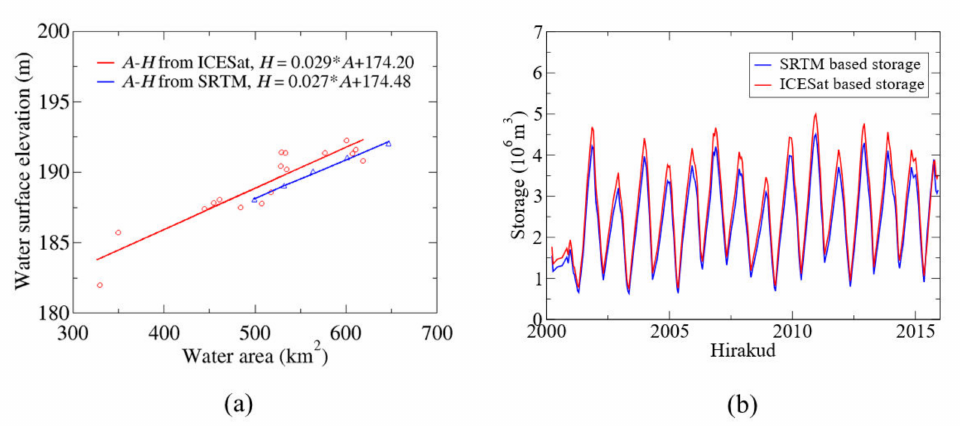
Figure 4. ( a ) The A - H relationship developed from SRTM compared with the relationship derived from ICESat, ( b ) time series of the storage estimation values for the Hirakud reservoir from both the SRTM- and the ICESat-based